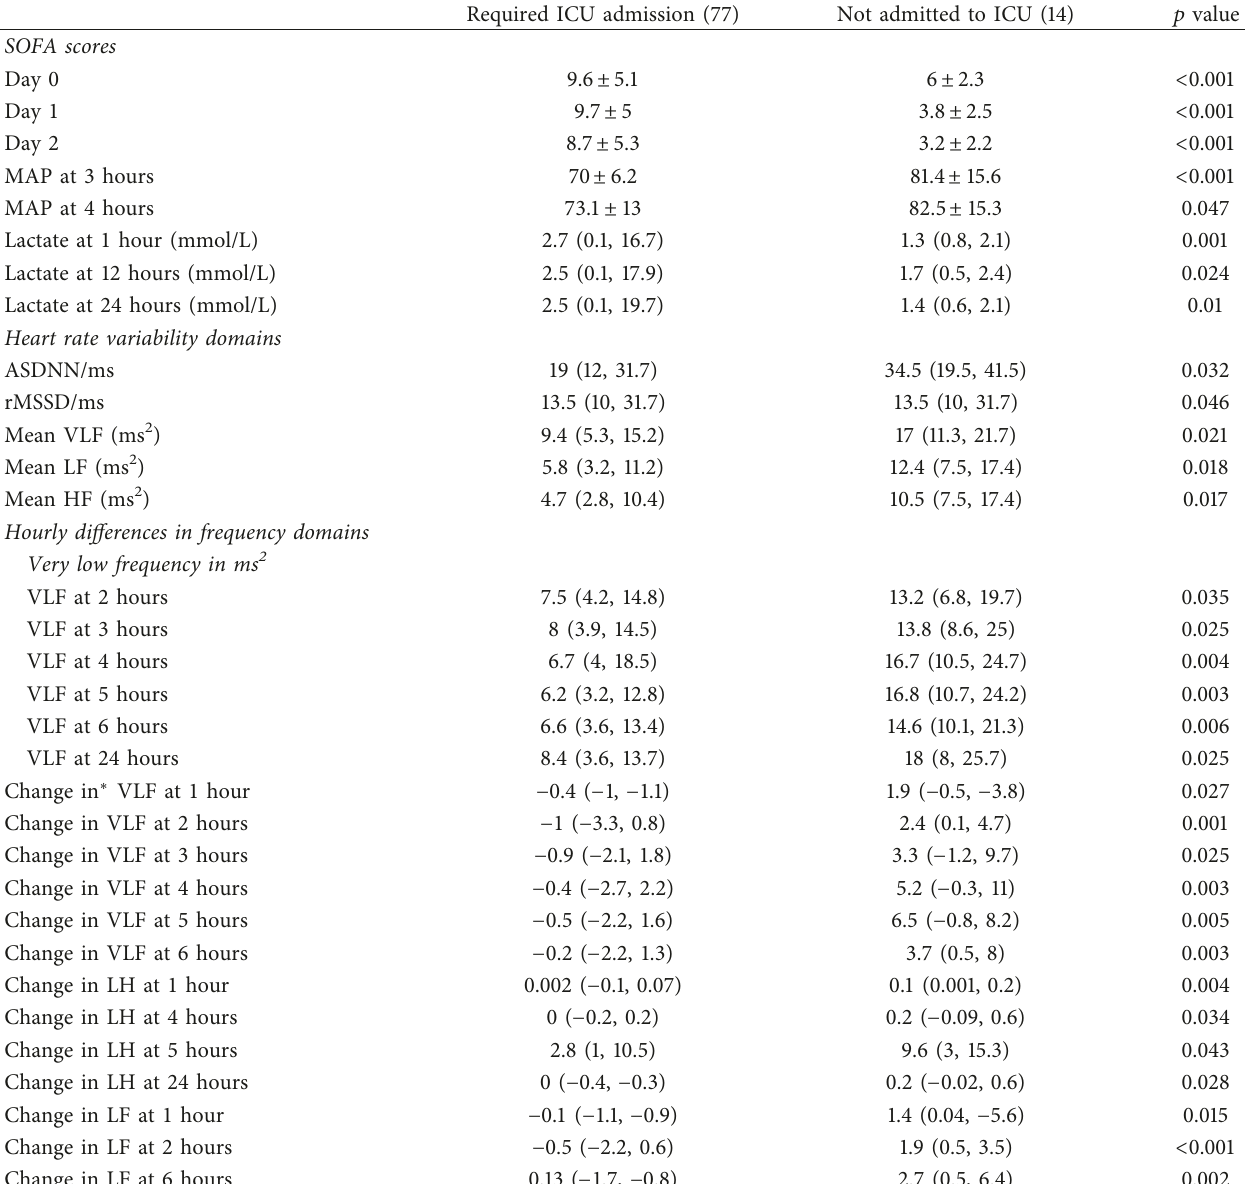
Table 3: Comparisons between RRT consultations who did or did not need ICU